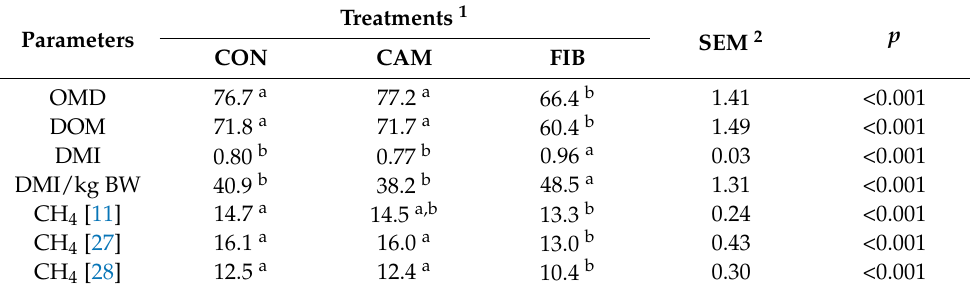
Table 3. Apparent in vivo organic matter digestibility (OMD, %) and digestible organic matter (DOM, % dry matter) of the diets at maintenance feeding level, and dry matter intake (DMI, kg/d), actual feeding level (g dry matter intake/kg body weight) and calculated methane (CH 4 ) production (g/d) of lambs according to Ramin and Huhtanen [11], Bell et al. [27] and Sauvant et al. [28]. Treatments 1 Parameters SEM 2 p CON CAM FIB OMD 76.7 a